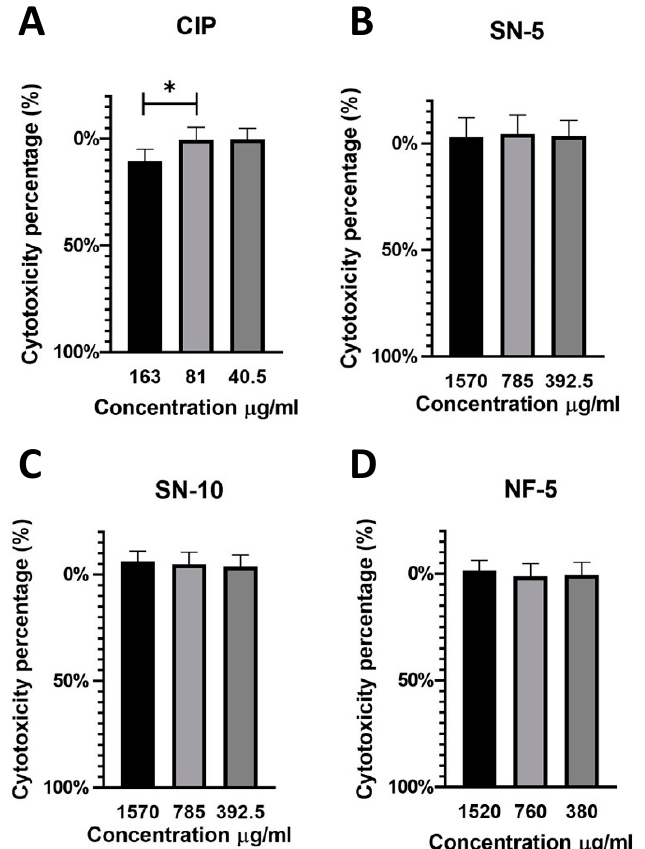
Figure 11. In vitro cytotoxicity measurement of the following solutions. ( A ) untreated ciprofloxacin (CIP) powder, ( B ) 5 w% CIP nanofibers produced using single-nozzle electrospinning, ( C ) 10 w% CIP nanofibers prepared using single-nozzle electrospinning, and ( D ) 5 w% CIP nanofibers produced using nozzle-free electrospinning. The solution of the untreated CIP powder was found to be cytotoxic at 163 µg/mL, but the solutions of different nanofibers were not cytotoxic in any of the measured concentrations (* p < 0.05).